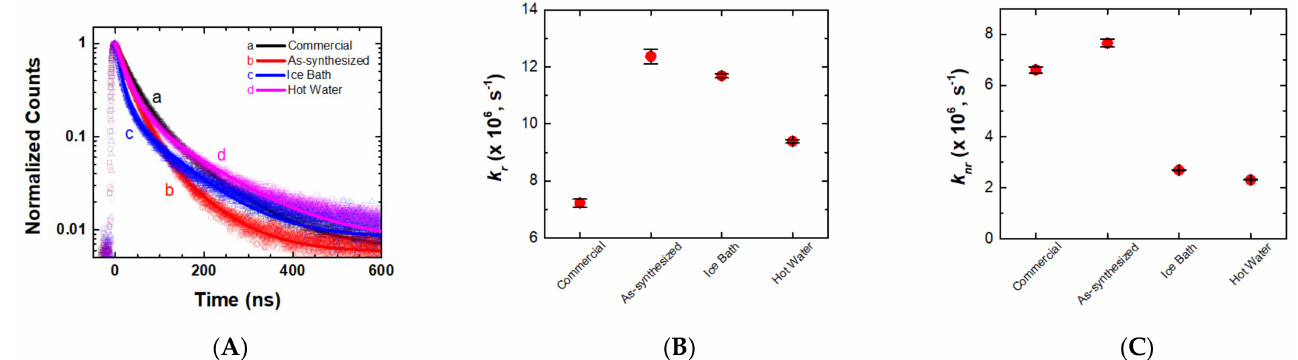
Figure 4. ( A ) Time-resolved photoluminescence decay kinetic traces of the four CsPbI3 PQDs made using (a) Commercial, (b) As-synthesized, (c) Ice Bath, (d) Hot Water PbI 2 , and their ( B ) k r and ( C ) k nr . Table 1. Averaged photoluminescence decay lifetime ( τ avg ), PLQY, k r , and k nr for the four CsPbI 3 PQDs made using the Commercial, As-synthesized, Ice Bath, and Hot Water PbI 2 . PbI 2 τ avg (ns) PLQY (%) k r (s − 1 ) k nr (s − 1 ) Commercial